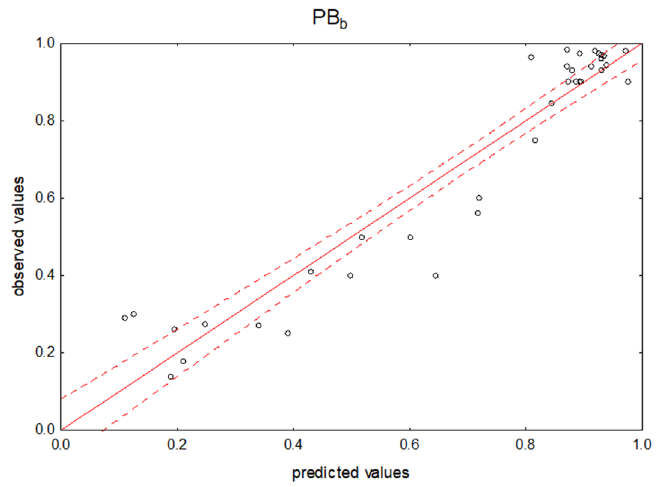
Figure A1. Predicted vs. observed values for MLR model using NP TLC retention data. Dependent variable: PB a .